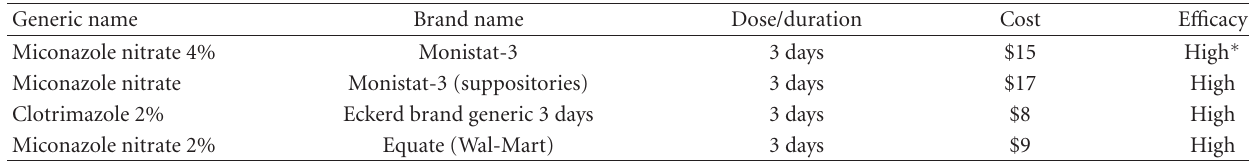
Table 2: Intra-vaginal Imidazoles. Three-day